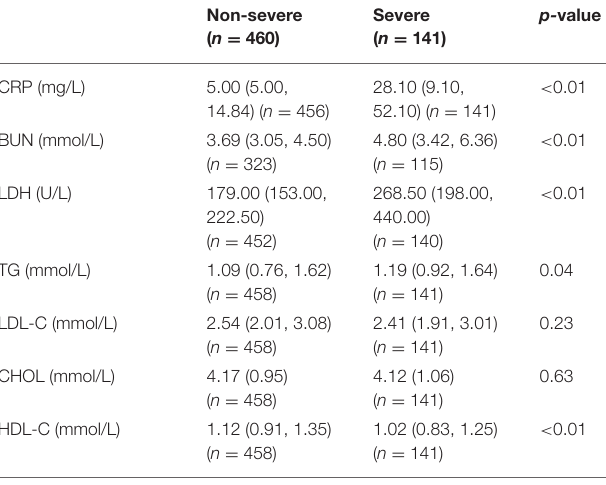
TABLE 1 | Baseline characteristics of COVID-19